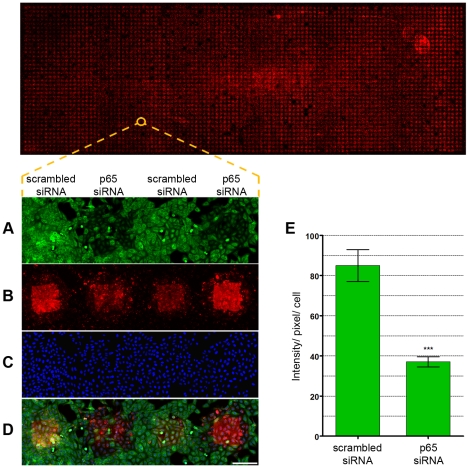
Proof-of-concept of the microarray screening.U2OS cells were seeded onto reverse transfection arrays comprising 250–300 µm spots spaced center-to-center at 500 µm intervals on a glass wafer. Spots contained p65 specific or control siRNAs (scrambled siRNA) and a red fluorescent siRNA in an encapsulation mixture (siGLO Red). Cells were incubated for 48 hours and then fixed and stained with anti-p65 antibodies. Confocal images were acquired 48 hours post-transfection. Scrambled siRNA was chosen as a negative control because it does not target any gene in the human genome. (A) Anti-p65 labeling of two p65 and two scrambled siRNA spots. (B) Spot images labeled with siGLO Red. (C) DNA staining (DRAQ5) showing an equal distribution of cells. (D) Overlay image. Scale bar represents 250 µm. (E) Quantification of p65 silencing using MetaXpress software (Molecular Devices). Plot showing p65 labeling (intensity/pixel/cell) for cells outside spots or overlaid on scrambled siRNA or p65 siRNA containing spots. ***p<0.0001 (unpaired t-test), n = 8.